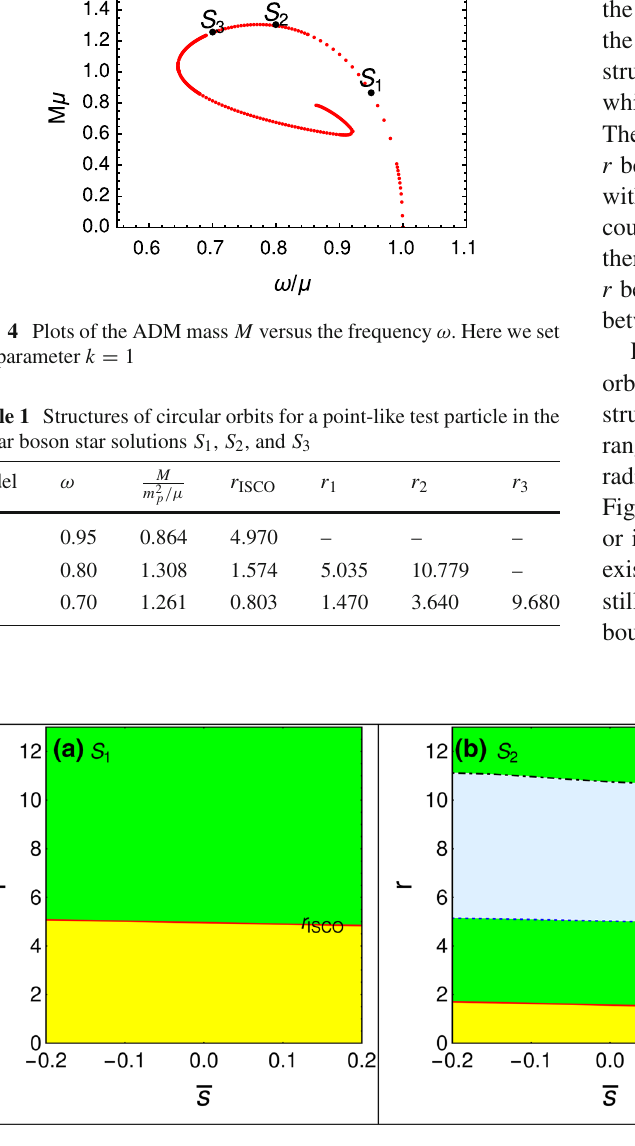
Fig. 5 Structuresofcircularorbitsofspinningtestparticleinthescalar boson star solutions S 1 , S 2 , and S 3 . Here, there are no circular orbits (timelike, null or spacelike) in the yellow region, there are stable time-